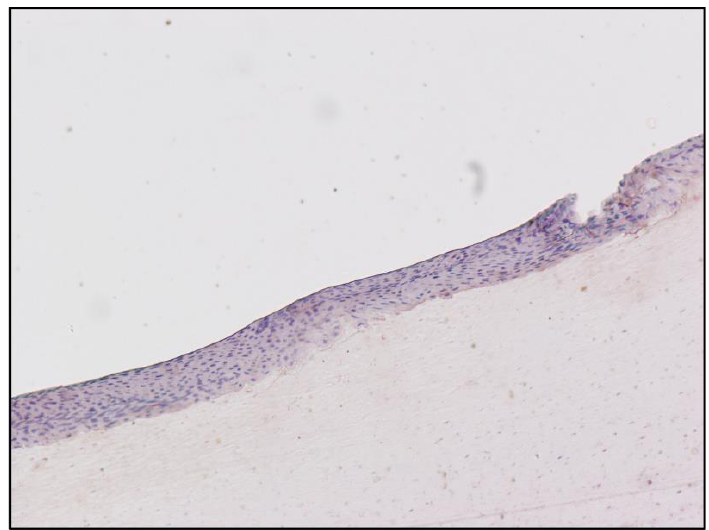
Figure 5. Immunoperoxidase staining for Sheep Anti-Morphine in the fingernail of Subject C, 10× magnification. The pictures show an absence of positivity for morphine in the nail matrix cells. Counterstaining with hematoxylin. Primary Ab: Polyclonal anti-Morphine Antibody produced in Sheep, dil. 1:100. Secondary Ab: Monoclonal Anti-Goat/Sheep IgG-Peroxidase Antibody produced in Mouse, dil. 1:100, original magnification: 10×.